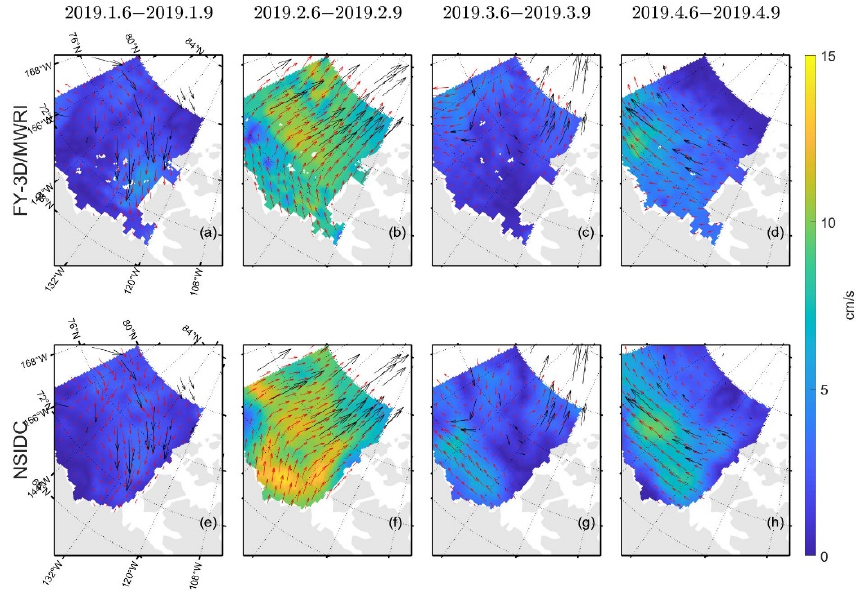
Figure 12. Schematic diagram of the sea ice motion retrieved by using FY ‐ 3D/MWRI T b data and the corresponding NSIDC product. Figure ( a )–( d ) show sea ice motion retrieved from FY ‐ 3D/MWRI T b data. Figure ( e )–( h ) show sea ice motion provided by NSIDC.